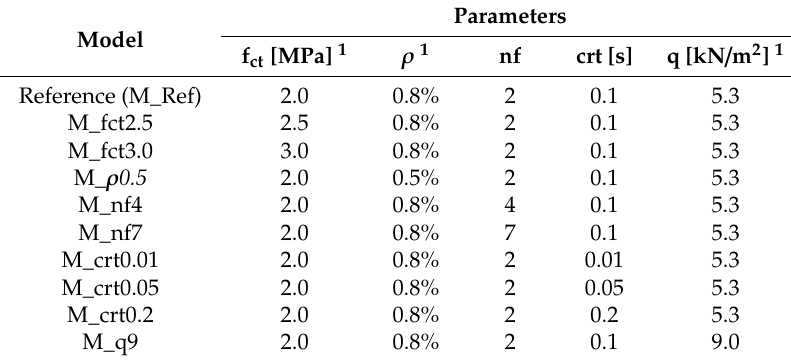
Table 3. Parametric